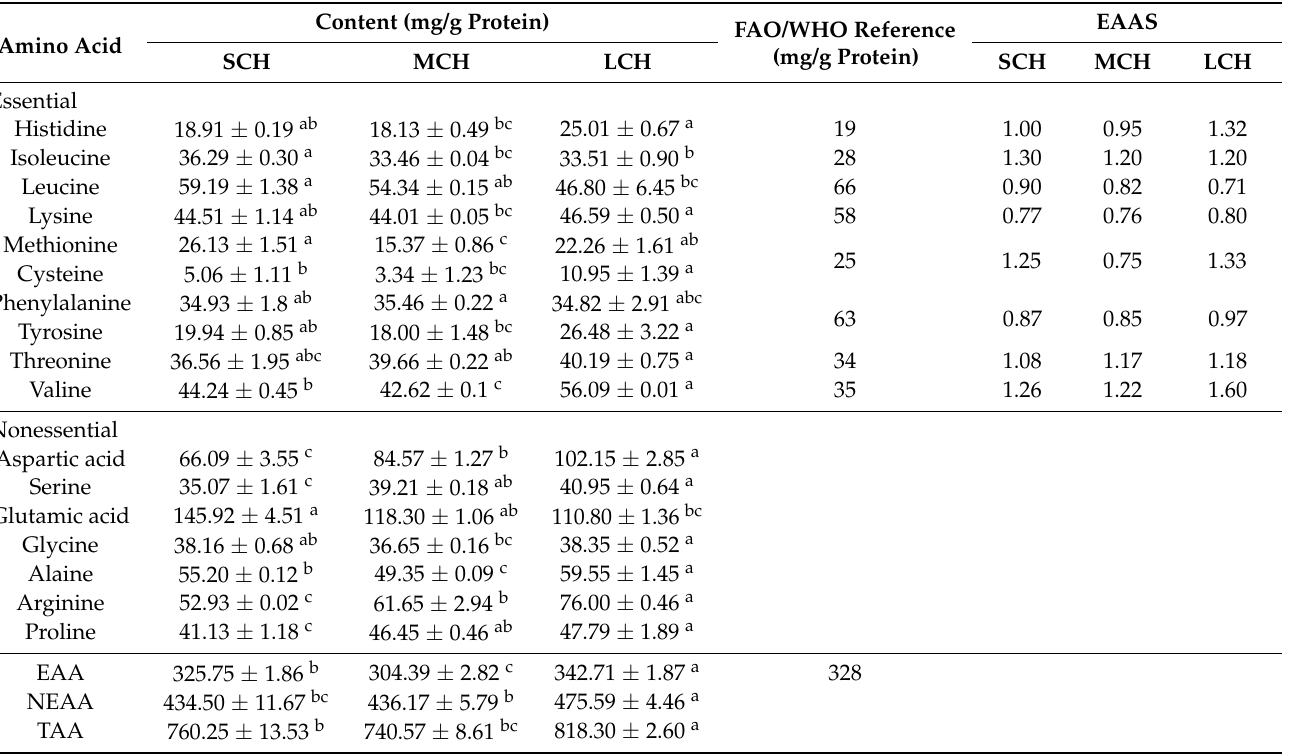
Table 3. Amino acid composition and essential amino acid score of coconut haustorium 1